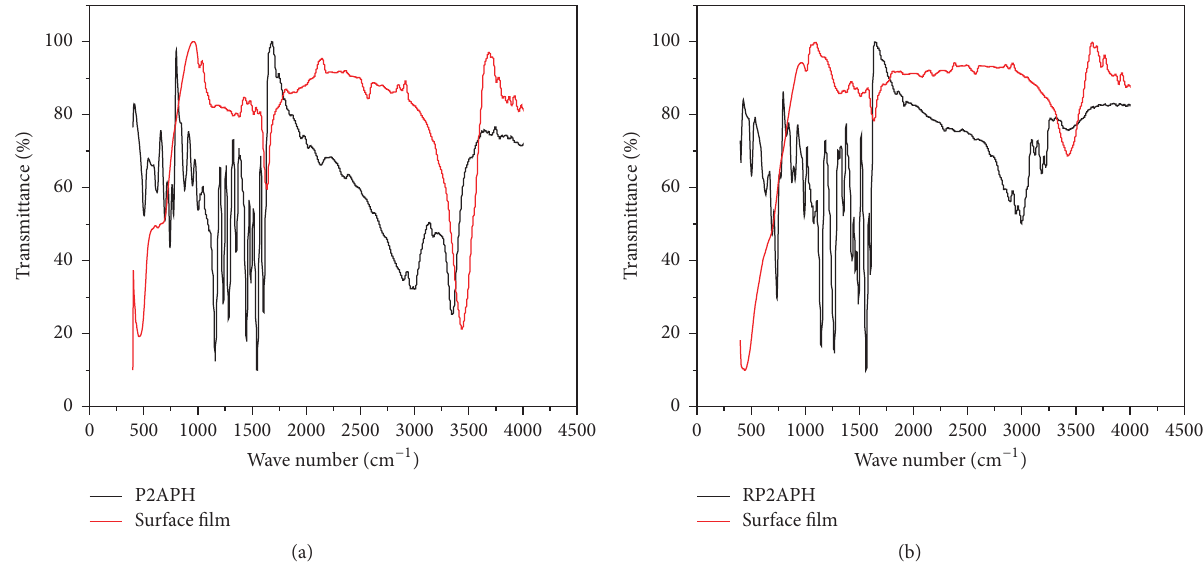
Figure 7: IR spectrum of (a) P2APH and surface film on CS; (b) RP2APH and surface film on